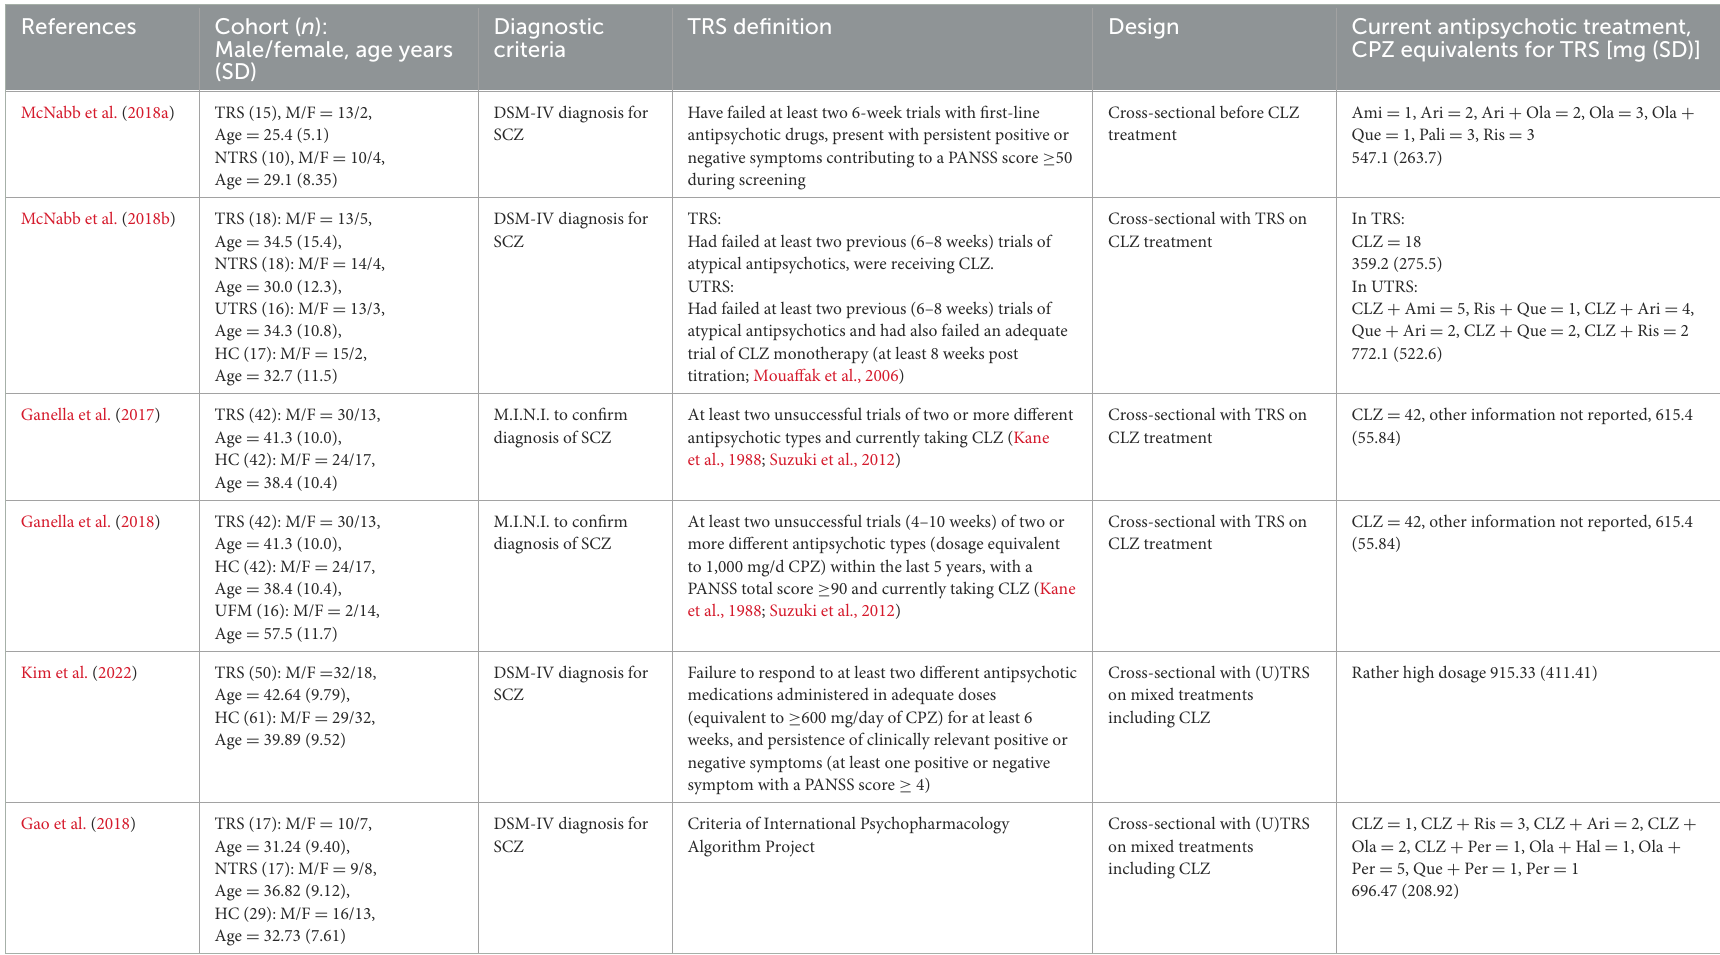
TABLE 1 Characteristics of included studies for treatment-resistant schizophrenia (TRS) which applied resting-state functional magnetic resonance imaging